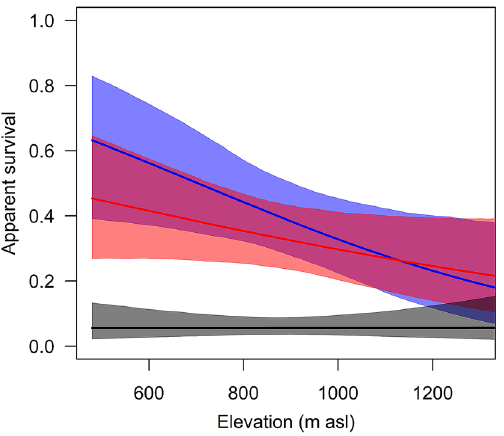
Figure 1. Model estimates of apparent survival probabilities in relation to elevation for females (red), males (blue), and juveniles (black). The shadowed areas indicate 95% credible intervals. N = 1531 ringed individuals (1337 nestlings, 194 adults) and 89 recaptured individuals.